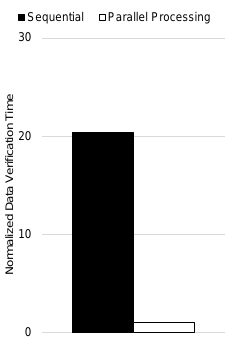
Figure 2. Data verification